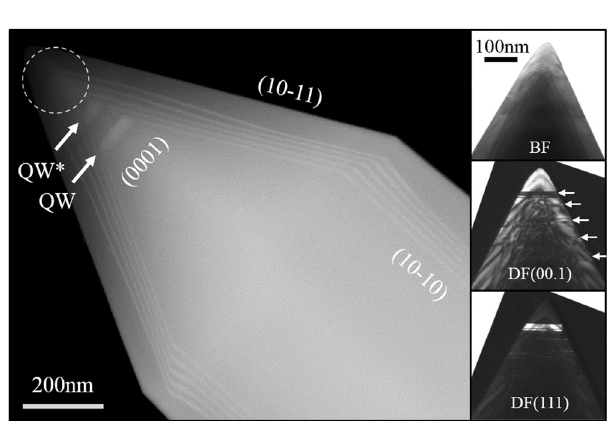
Figure 1. Sketch of the pulsed selective area epitaxy of the n-GaN core followed by a standard 5-InGaN-QW/p- GaN shell deposition ( A ). The resulted NR array is shown on the SEM pictures ( B and C ).